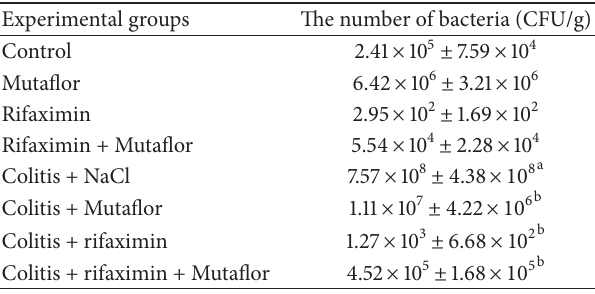
Figure 5: Influence of E. coli Nissle 1917 (Mutaflor) and rifaximin on of interleukin-1 𝛽 concentration in colonic mucosa in rats without or with acetic acid-induced colitis. Mean value ± SEM. 𝑁 = 8 animals in each experimental group. a 𝑃 < 0.05 compared to control saline-treated rats without induction of colitis; b 𝑃 < 0.05 compared to colitis + NaCl; c 𝑃 < 0.05 compared to colitis + Mutaflor; and d 𝑃 < 0.05 compared to colitis + rifaximin. Table 2: Influence of treatment with Escherichia coli Nissle 1917 (Mutaflor) and/or rifaximin and induction of colitis on the total number of Escherichia coli identified by qPCR in feces